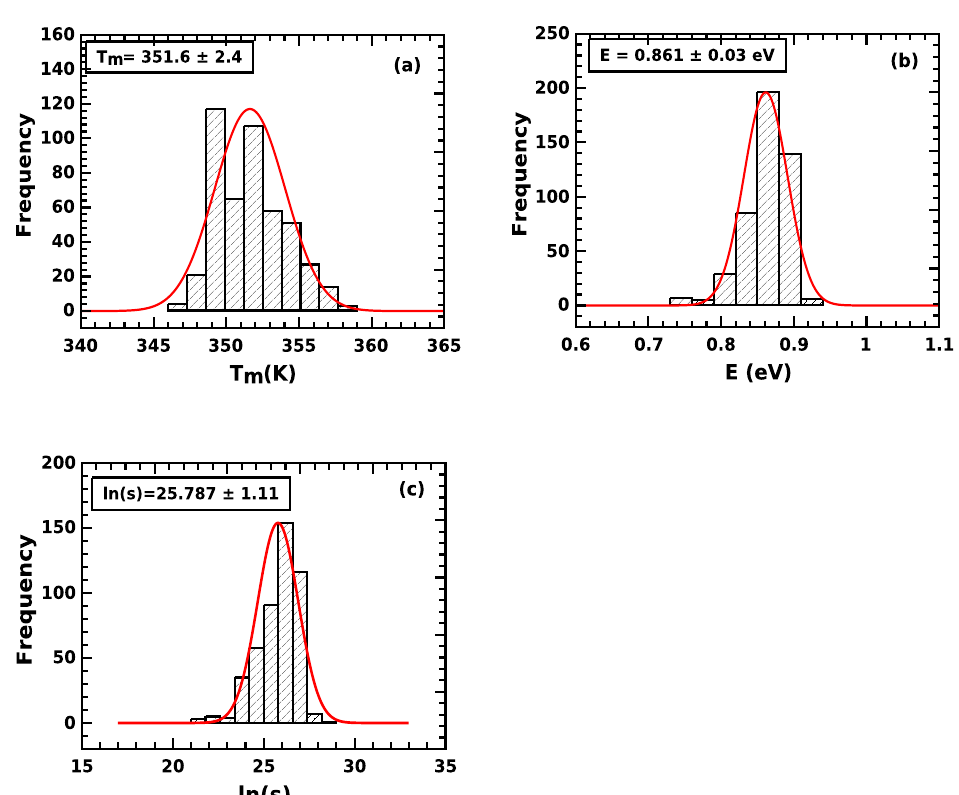
Figure 5. ( a ) Histogram for the position of peak maximum temperature, ( b ) histogram for the values of the activation energy and ( c ) histogram of the logarithm of the frequency